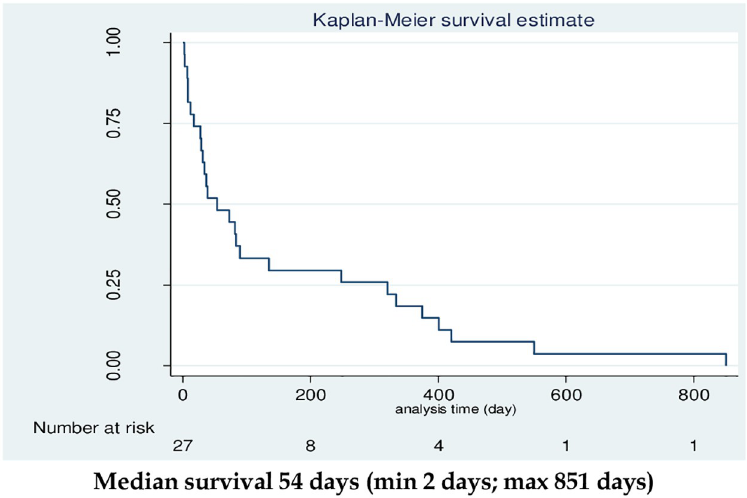
Fig 2. Kaplan Meier survival analyses of 27 HCC patients.